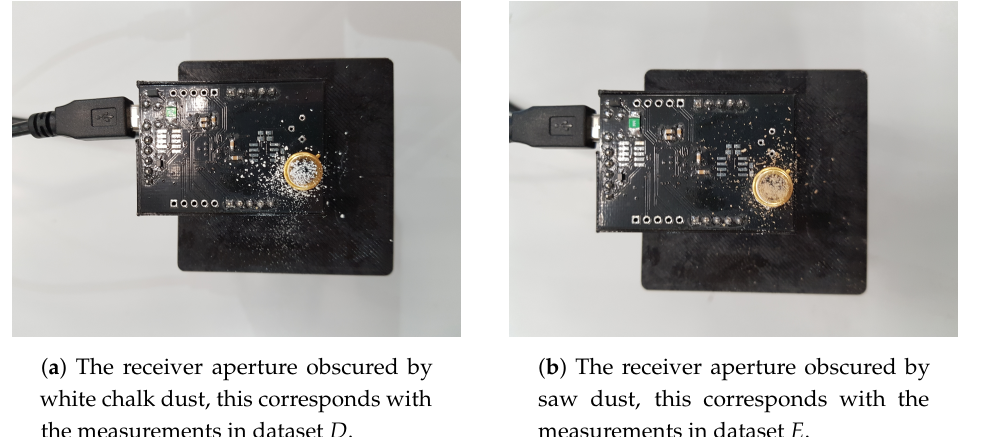
Figure 8. A block schematic representation of the receiver on a system level.